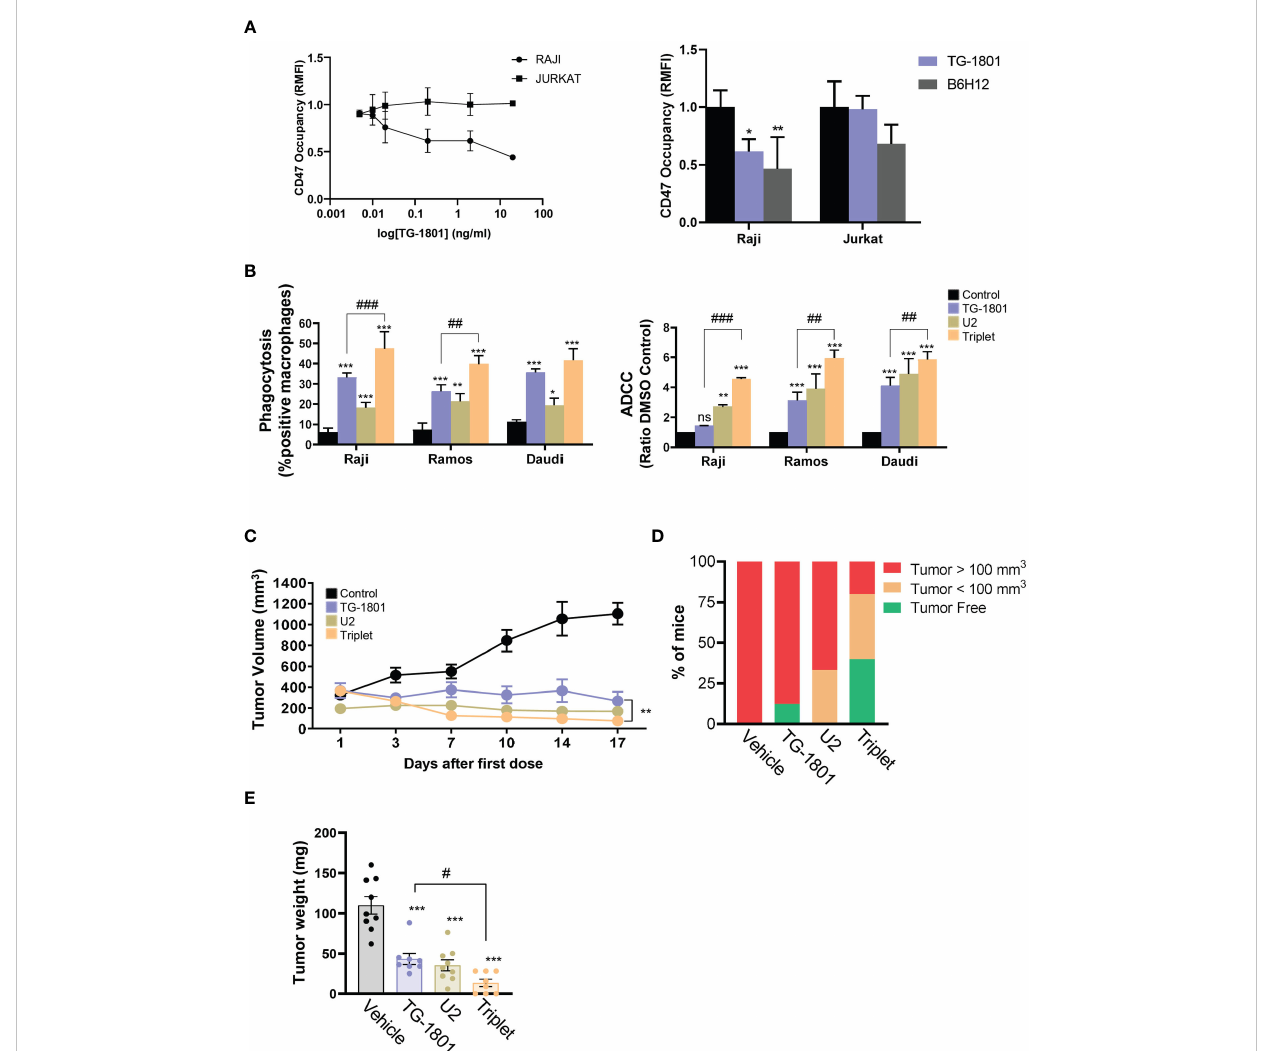
FIGURE 1 U2 regimen cooperates with CD47 blockade in in vitro and in vivo models of B-cell lymphoma. (A) FACS-mediated CD47 occupancy assay in the CD19+ Burkitt lymphoma cell line Raji, and in the CD19- T-ALL cells Jurkat, treated for 1h with different doses of TG-1801 or B6H12. Results are expressed in Relative median fl uorescence intensity (RMFI) of the PE-labelled anti-CD47 antibody. Left panel is a dose-occupancy curve of Raji and Jurkat cell lines with different doses of TG-1801. Right panel is a comparison between TG-1801 and B6H12 at 2µg/ml (n=3). (B) ADCP (left panel) and ADCC (right panel) activities were assessed in three representative BL cell lines (N=3). Values are expressed as mean ± SD. (C) NOD/SCID IL2R g - null (NSG) mice were inoculated subcutaneously with 10 7 Raji cells and after 14 days, tumour-bearing animals (n=6-8 mice per group) were orally dosed for 17 days with TG-1801 (5 mg/kg, qw), ublituximab (5 mg/kg, qw) + umbralisib (U2) (150 mg/kg, bid), the triplet (TG-1801 + U2), or an equal volume of vehicle. Tumour volumes were measured each 2-3 days with external callipers. (D) Mice with no tumour or low tumour size were kept alive for another 35 days. At day 52 all the mice either tumour-free (green) or bearing a small tumour (orange, < 100 mm 3 ) were alive. The triplet combo group showed a higher number of tumour-free or low tumour burden-bearing mice. (E) Weight recording of Raji CAM-derived tumour at day 15 exposed to TG-1801, U2 or triplet combination (n=8-10 replicates per treatment group). * p <0.05, ** p <0.01, *** p <0.001, when compared to control group. # p<0.05, ## p <0.01 and ### p <0.001 when compared to TG-1801 alone. ns, non-signi fi